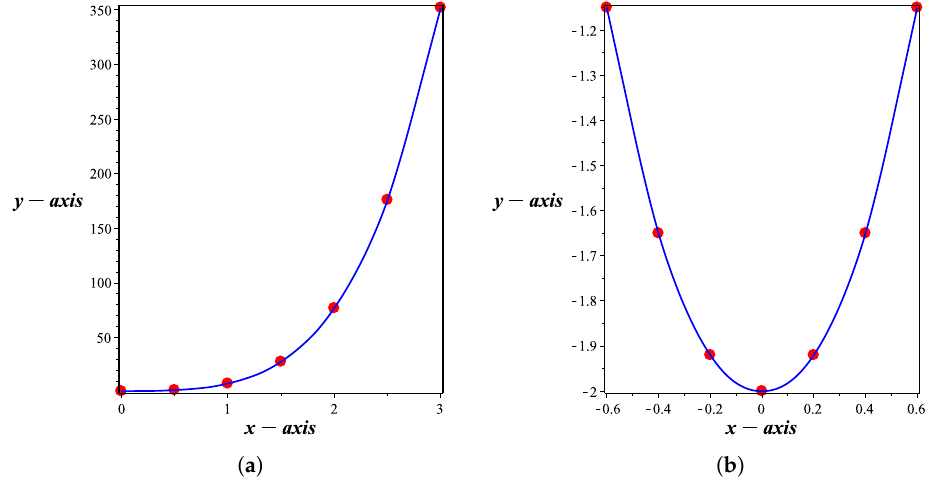
Figure 8. The convex curves generated by the FPR -scheme (4). ( a ) Convex curve at u = 0 and ( b ) Convex curve at u =